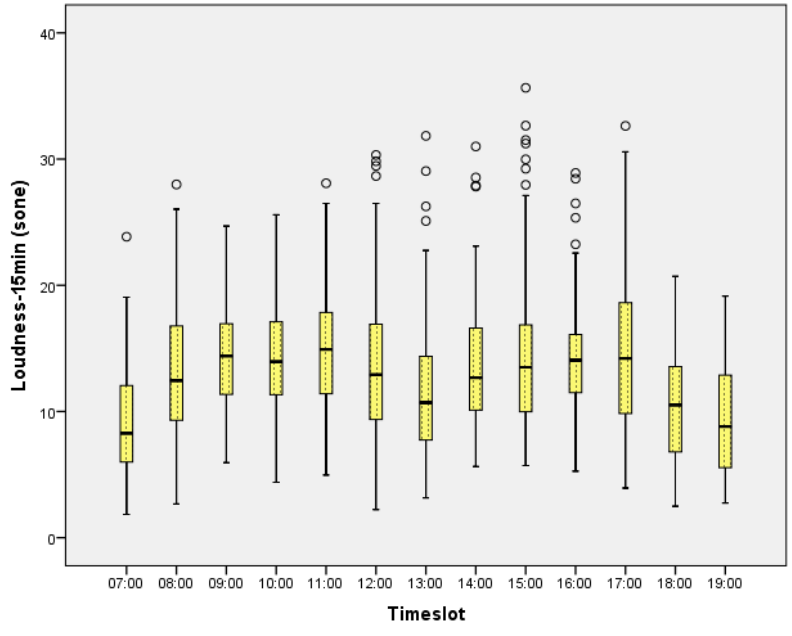
Figure 11. Distributions of Loudness -15min scores as a function of the time slot.